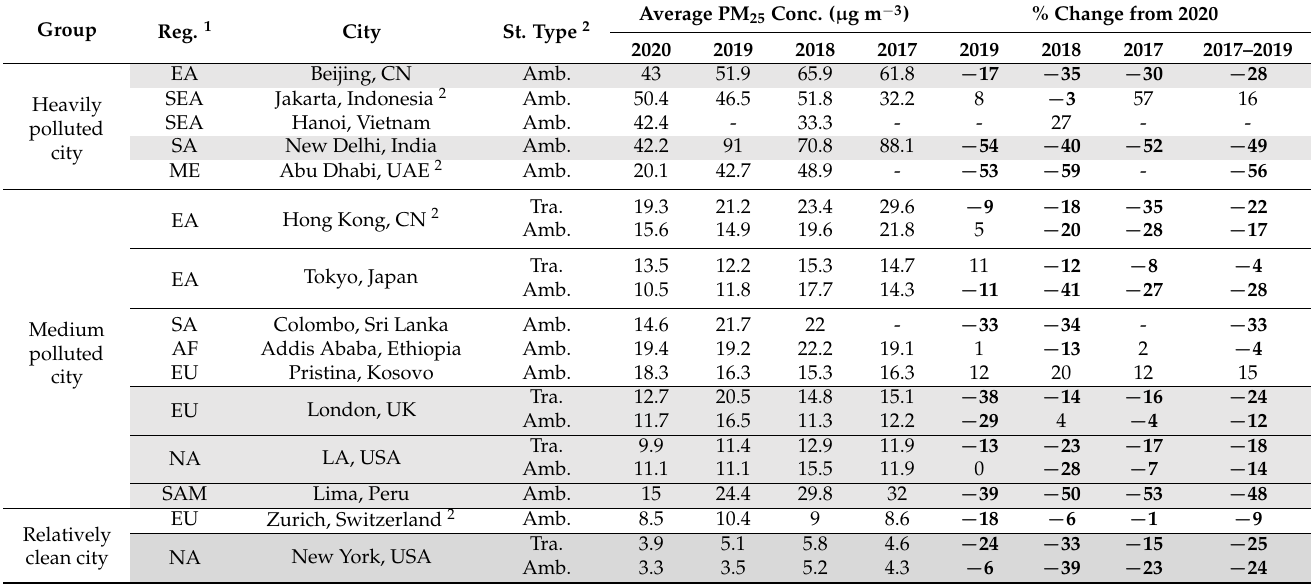
Table 2. Summary of PM 2.5 air quality for selected